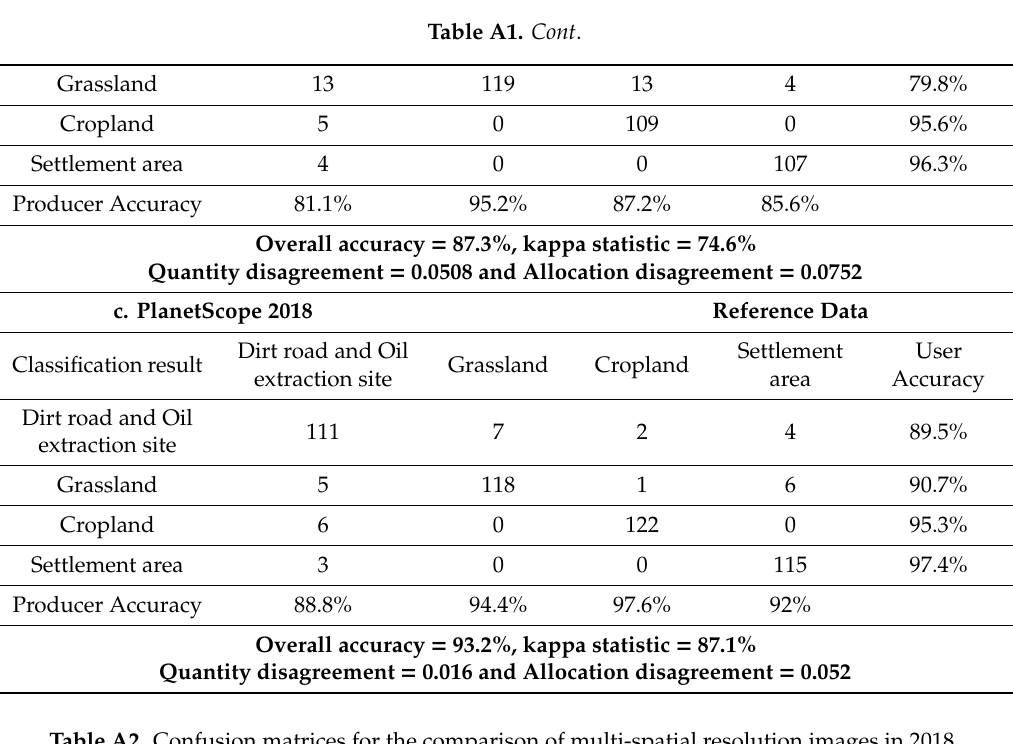
Table A2. Confusion matrices for the comparison of multi-spatial resolution images in 2018. a. PlanetScope